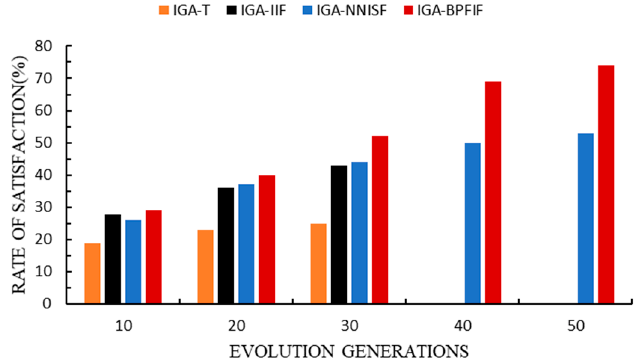
Figure 8. Comparison of satisfaction.